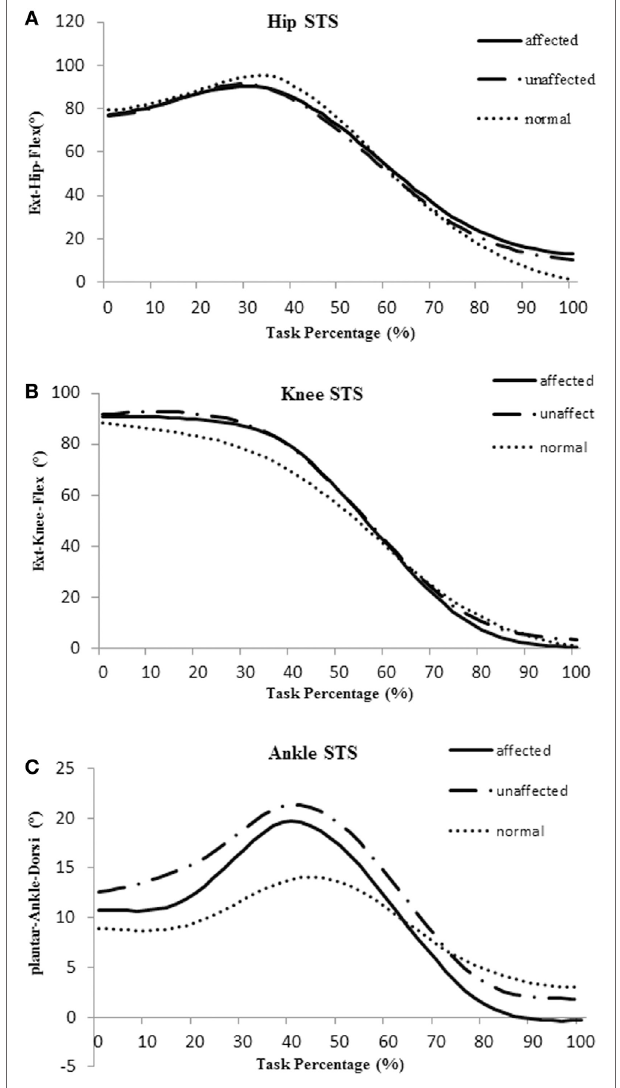
FigUre 2 | Averaged joint angle curves of hip (a) , knee (b) , and ankle (c) during sit-to-stand (STS) movement in the affected side (blue), unaffected side (red), and healthy control group